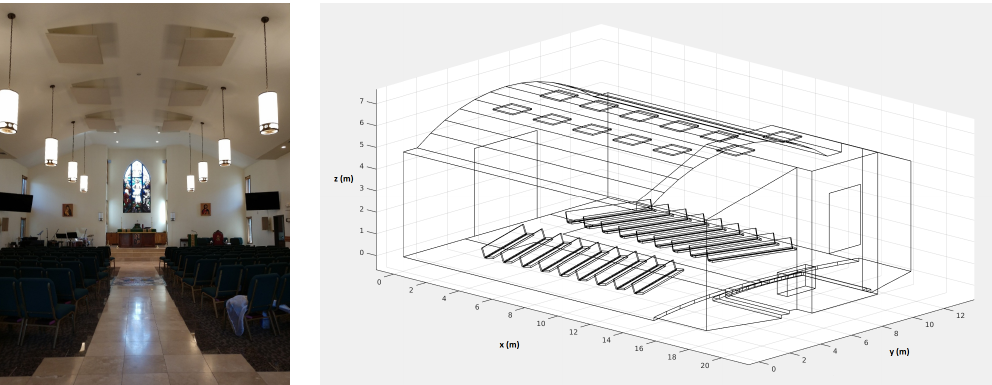
Figure 1. ( left ) photograph of Christ the King (CTK) church taken after remediation. The main aisle is in view, along with absorbing panels mounted under the barrel-vaulted ceiling. ( right ) Simplified computer-aided design (CAD) model of CTK church after remediation with axis units in